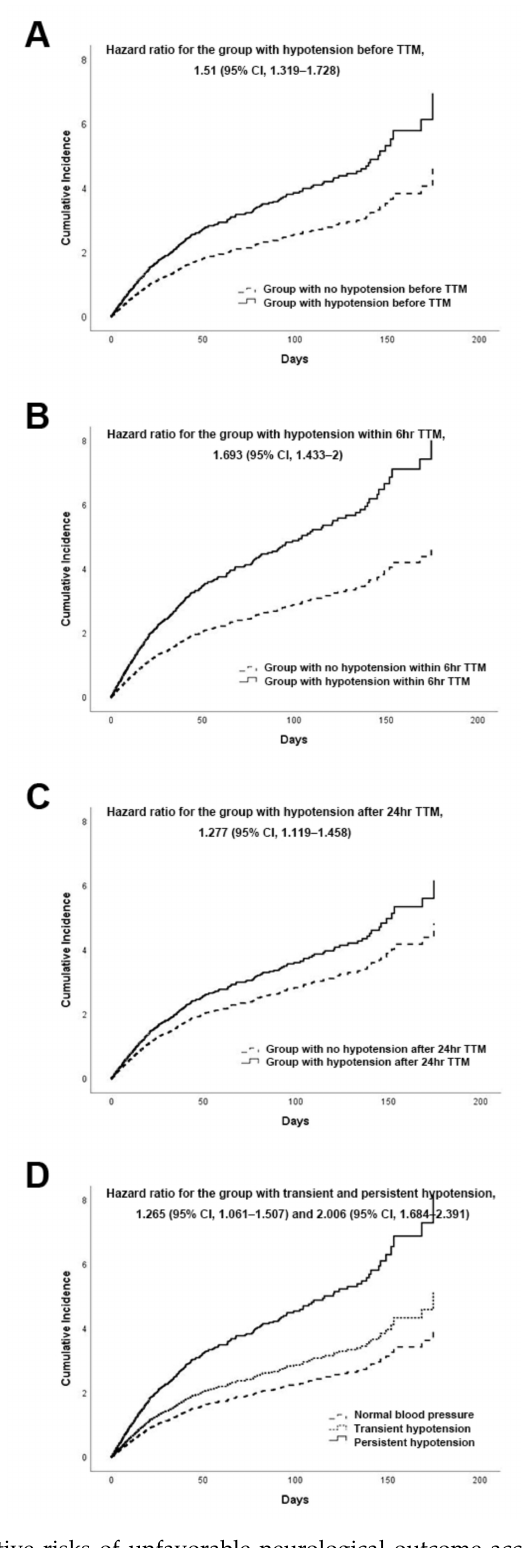
Figure 4. The cumulative risks of unfavorable neurological outcome according to the timing of hypotension episodes. Cumulative incidence curves for the hypotension group before TTM ( A ), the hypotension group within 6 h after TTM ( B ), the hypotension group 24 h after TTM ( C ), and the group with hypotension episodes both before TTM initiation and during the TTM period ( D ) as compared with those for the normal blood pressure